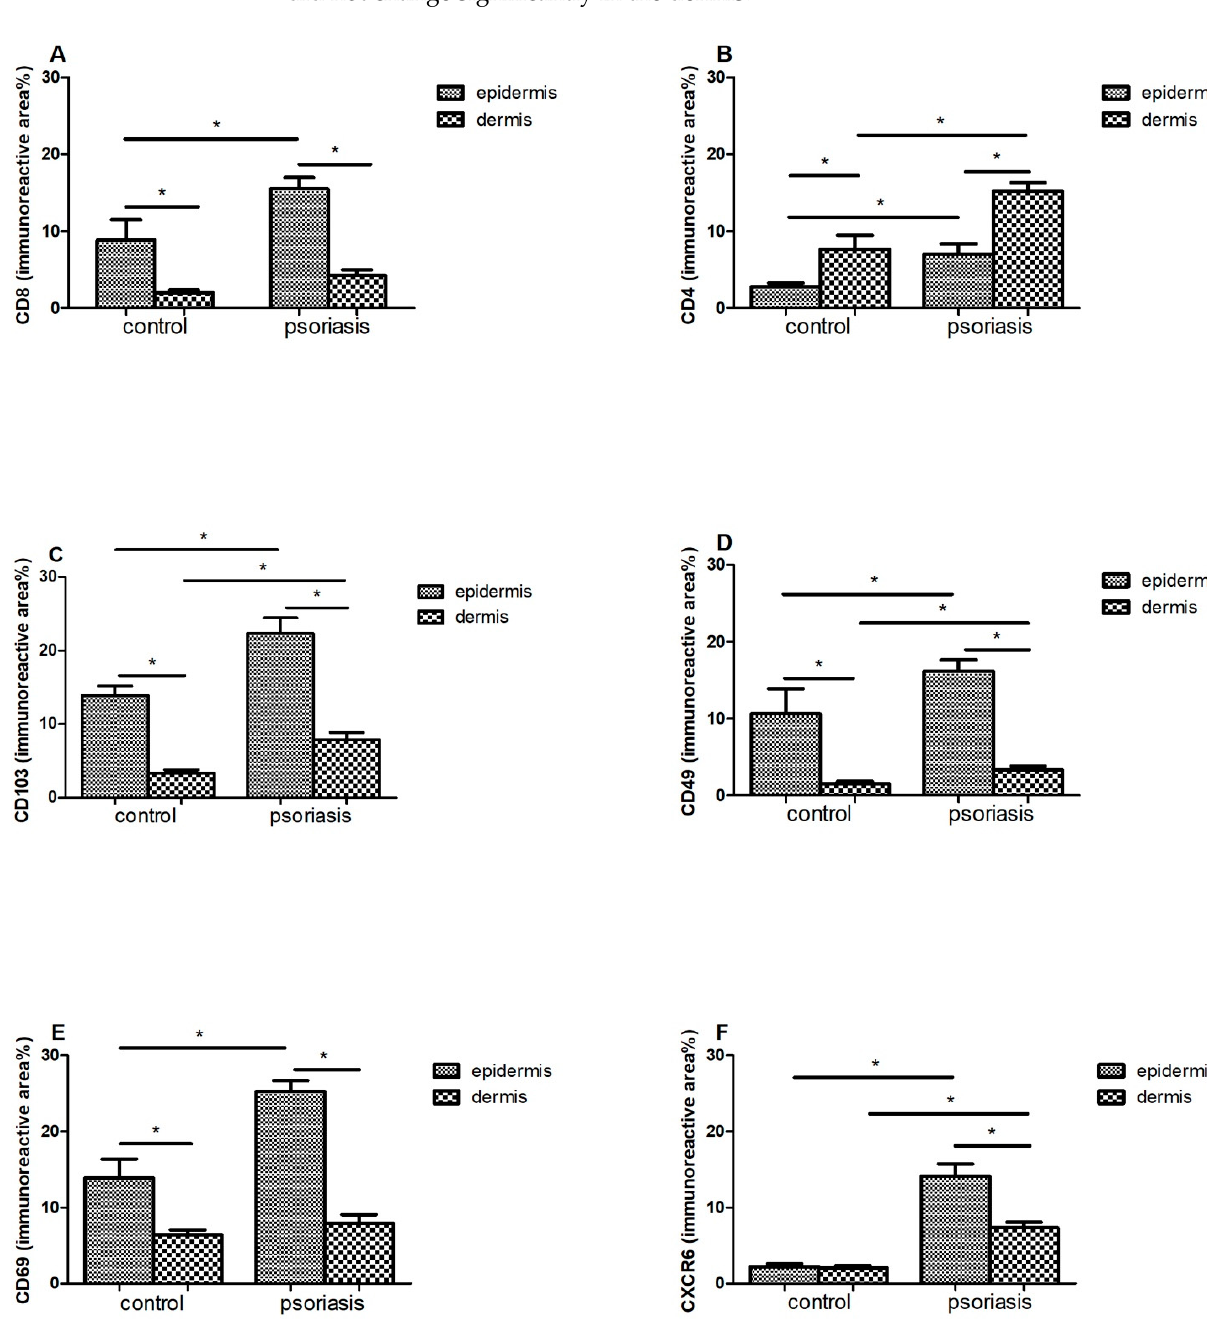
Figure 3. Immunoreactive area (means ± SEM) of ( A ) CD8; ( B ) CD4; ( C ) CD103; ( D ) CD49; (E) CD69; ( F ) CXCR6; ( G ) IL- 17A; ( H ) IL-22 in lesional skin ( n = 32, dermis and epidermis) in comparison with healthy control ( n = 10, dermis and epidermis). Bars with asterisks are significantly different ( p < 0.05, Mann–Whitney U test).